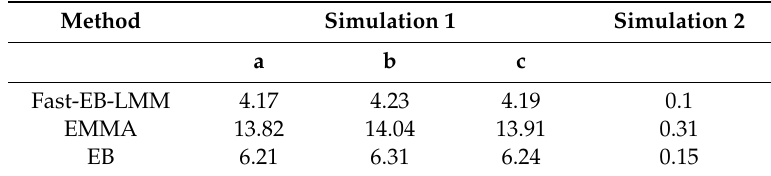
Table 2. Comparison of times taken (Hrs) in the detection of QTNs in the two simulation experiments using the three di ff erent methods.